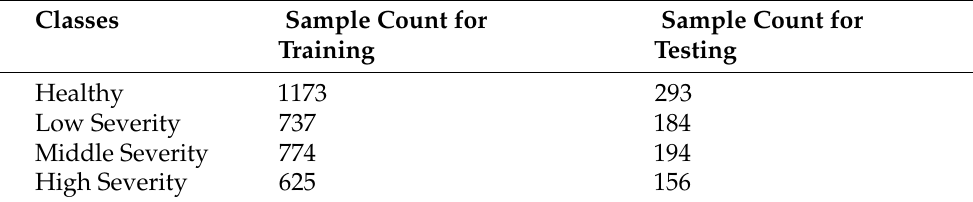
Table 1. Citrus sample counts in training and